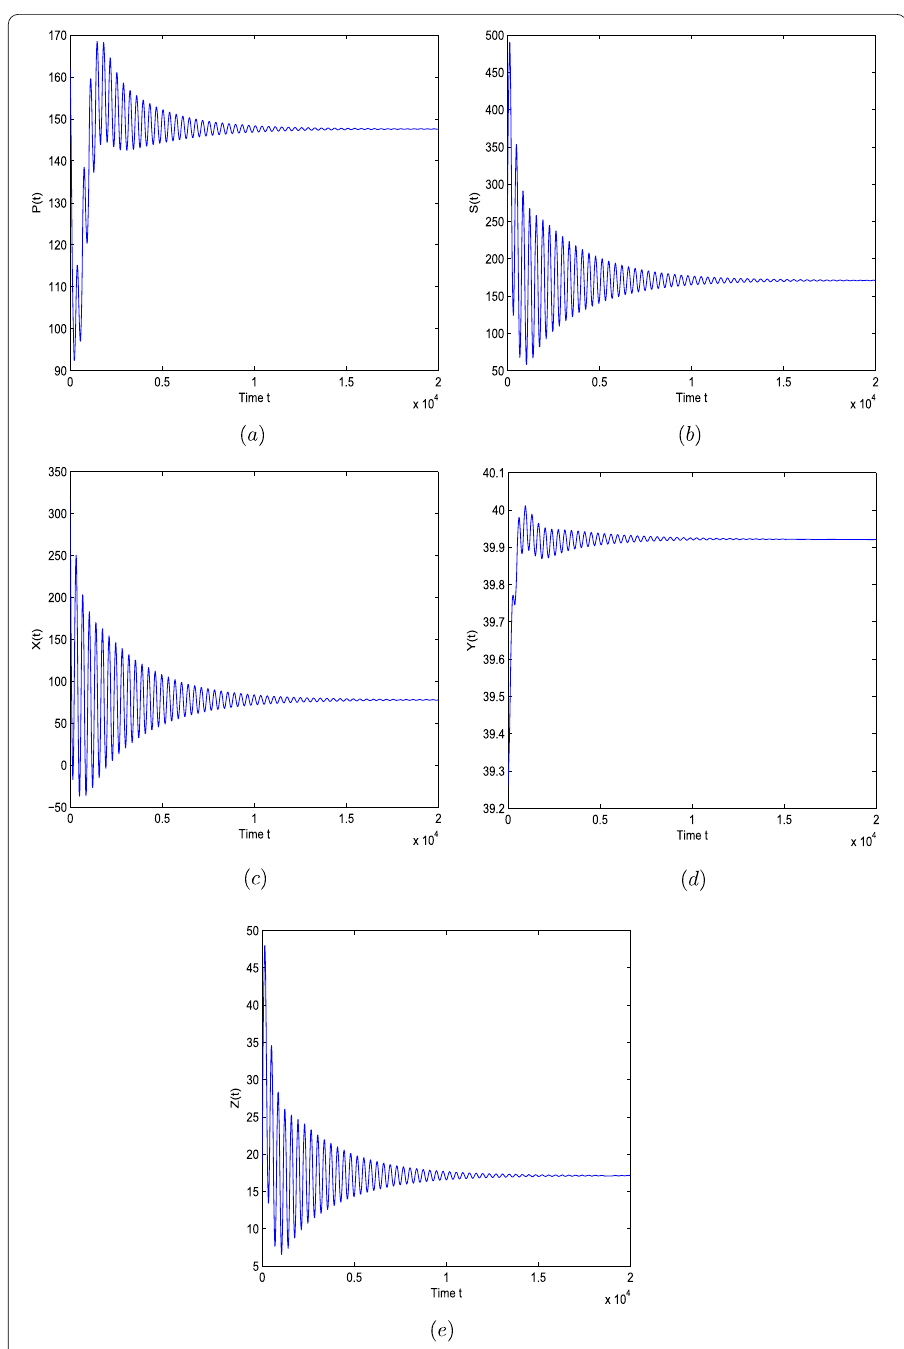
Figure 2 The equilibrium E ∗ of system (21) is asymptotically stable for τ = 114.685 < τ 0